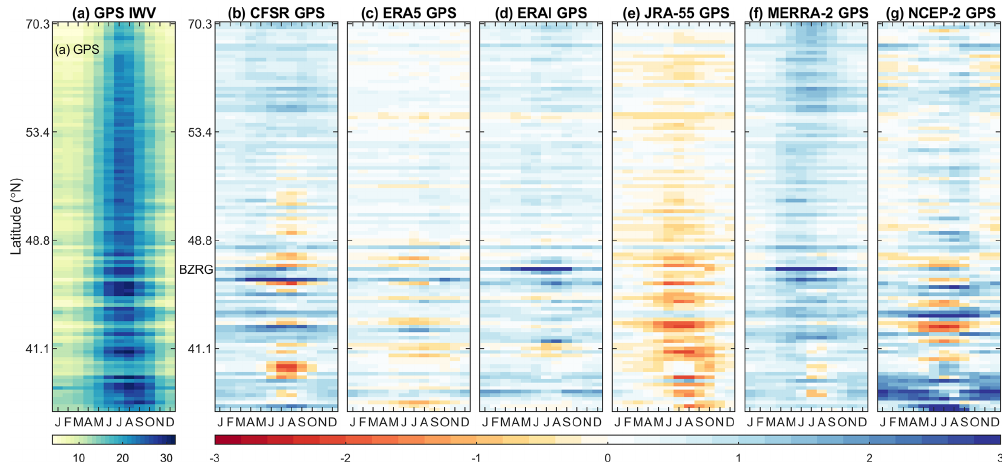
Figure 11. (a) Monthly annual cycle of GPS IWV in kilogram per square metre for the 108 GPS stations with increasing latitude from the bottom to the top. (b–g) The differences between the annual cycles of the various reanalyses compared to the